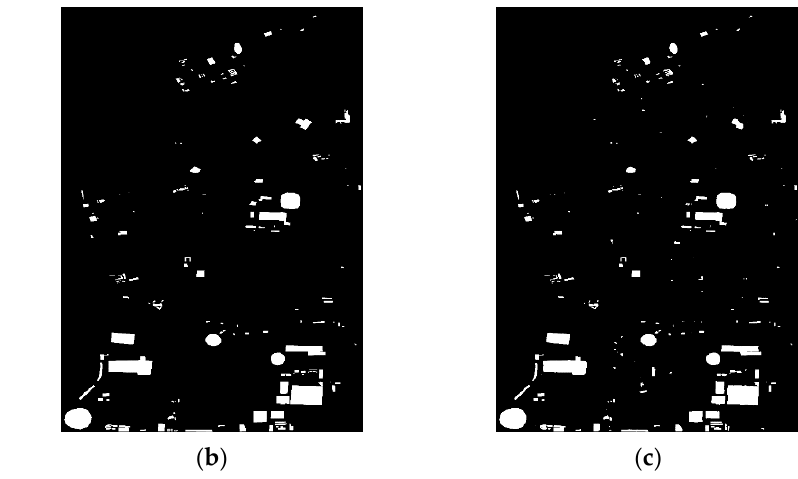
Figure 7. Original image, building ground truth value, and extraction results of the emergency shelter in Chaoyang Park. ( a ) Original image. ( b ) Ground truth. ( c ) Extraction results. Five local areas of A, B, C, D, and E in the emergency shelter of Chaoyang Park were selected to see the details of the experimental results clearly. Figure 8 shows the original image, the corresponding ground truth, and extraction results.